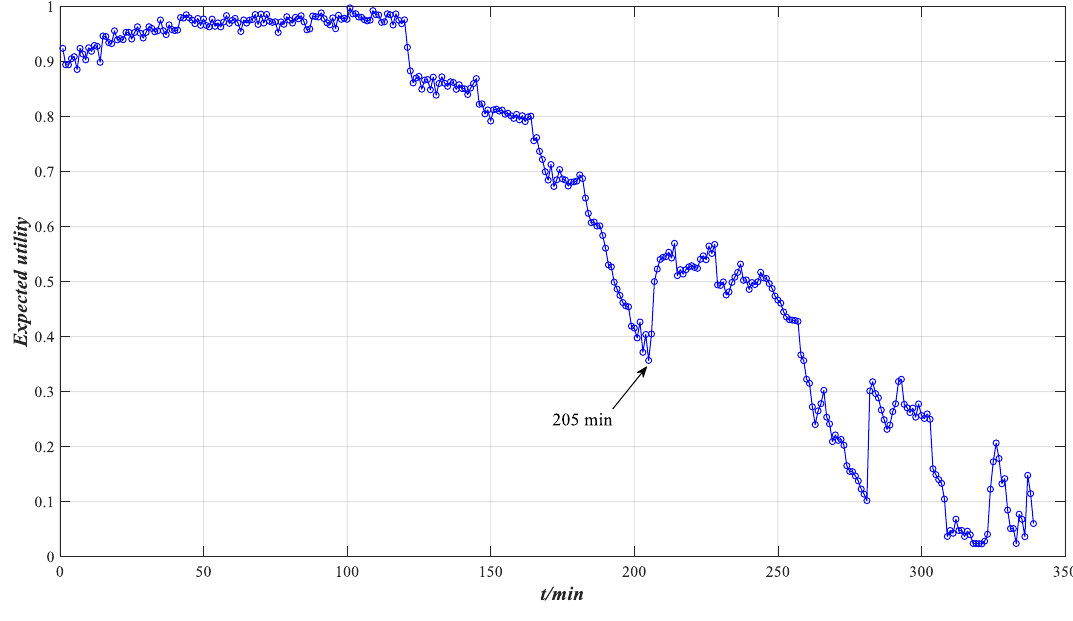
Figure 28. Expected utility of XJTU-SY bearing performance.